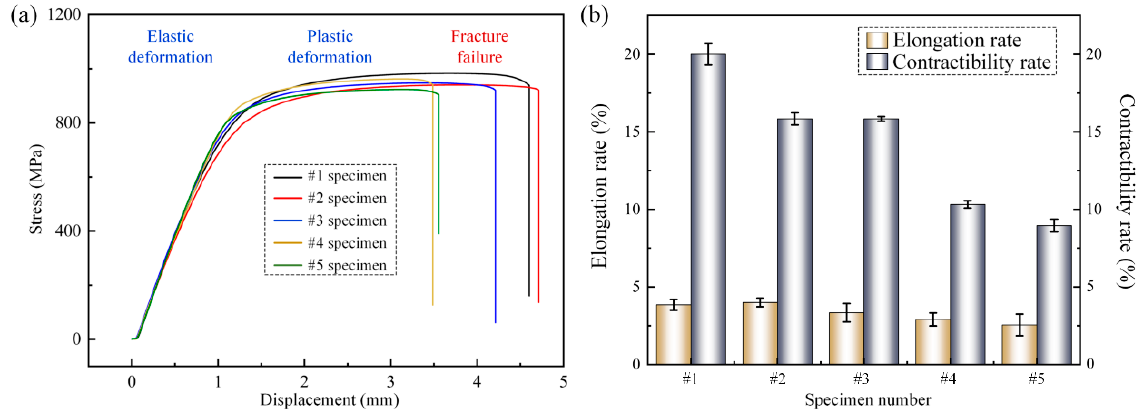
Figure 14. Tensile property test results: ( a ) the displacement-stress variation curve of tensile speci- mens, ( b ) the elongation at break and the shrinkage at section of tensile specimens.